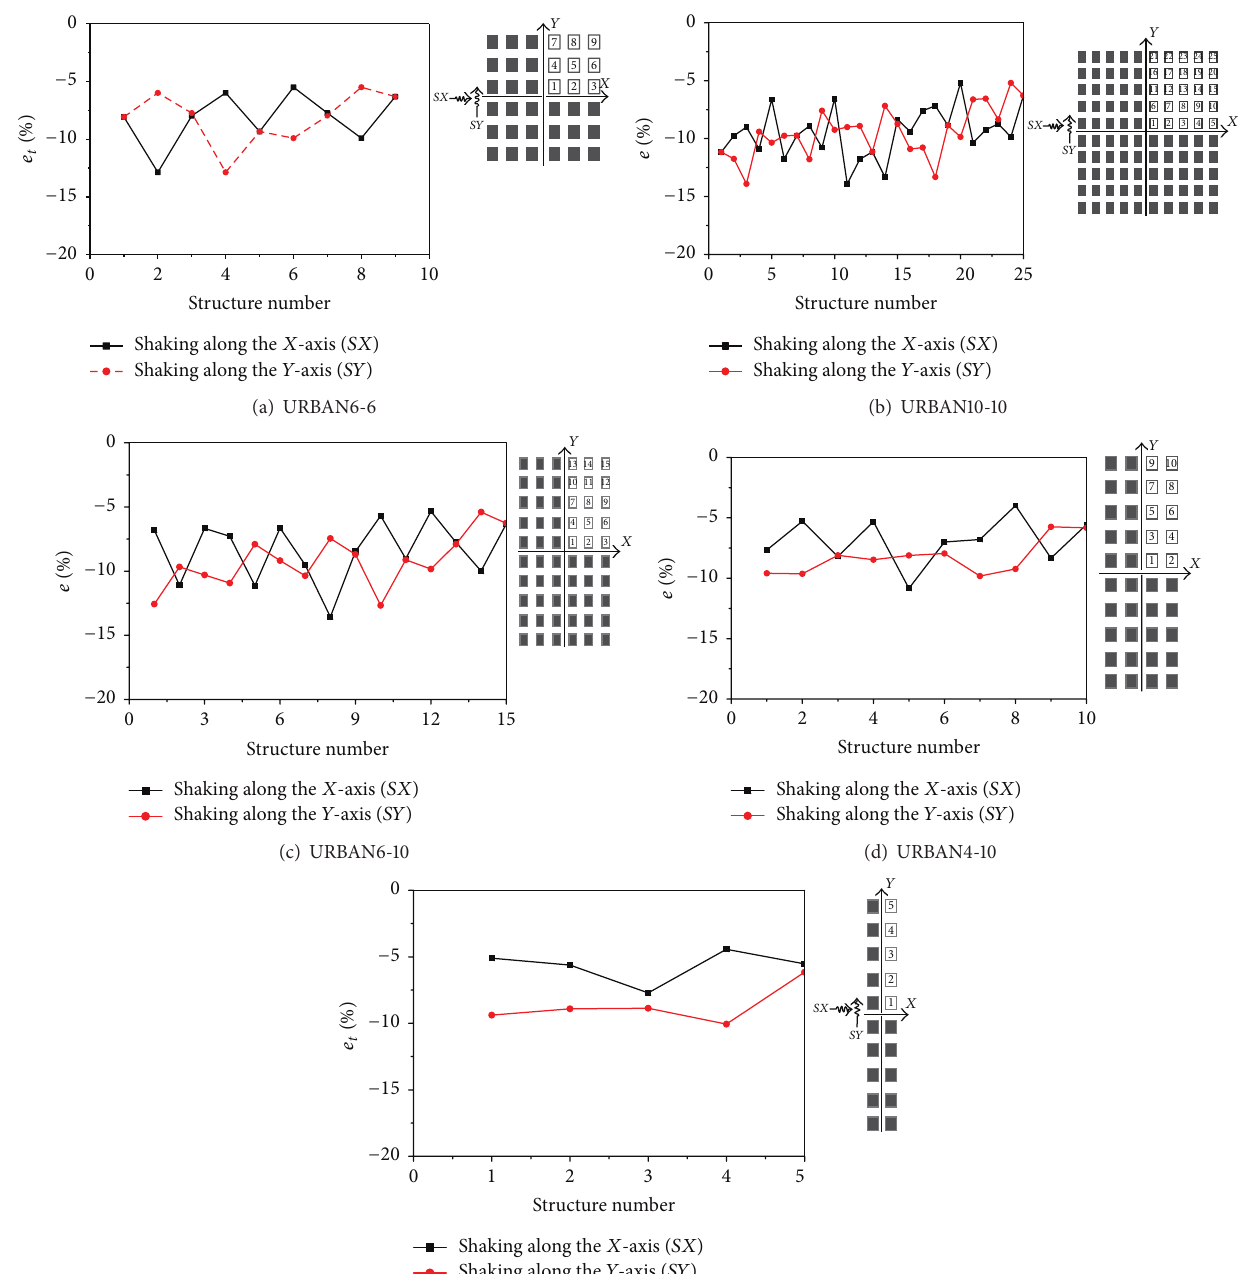
Figure 23: Interaction among structures in terms of influence coefficient 𝑒 𝑡 for structural groups with different arrangements ( 𝐷 = 0.5 , MCH000, 𝑆𝑋 or 𝑆𝑌 ). The arrangement is shown in the schematic diagram in the top-right corner.